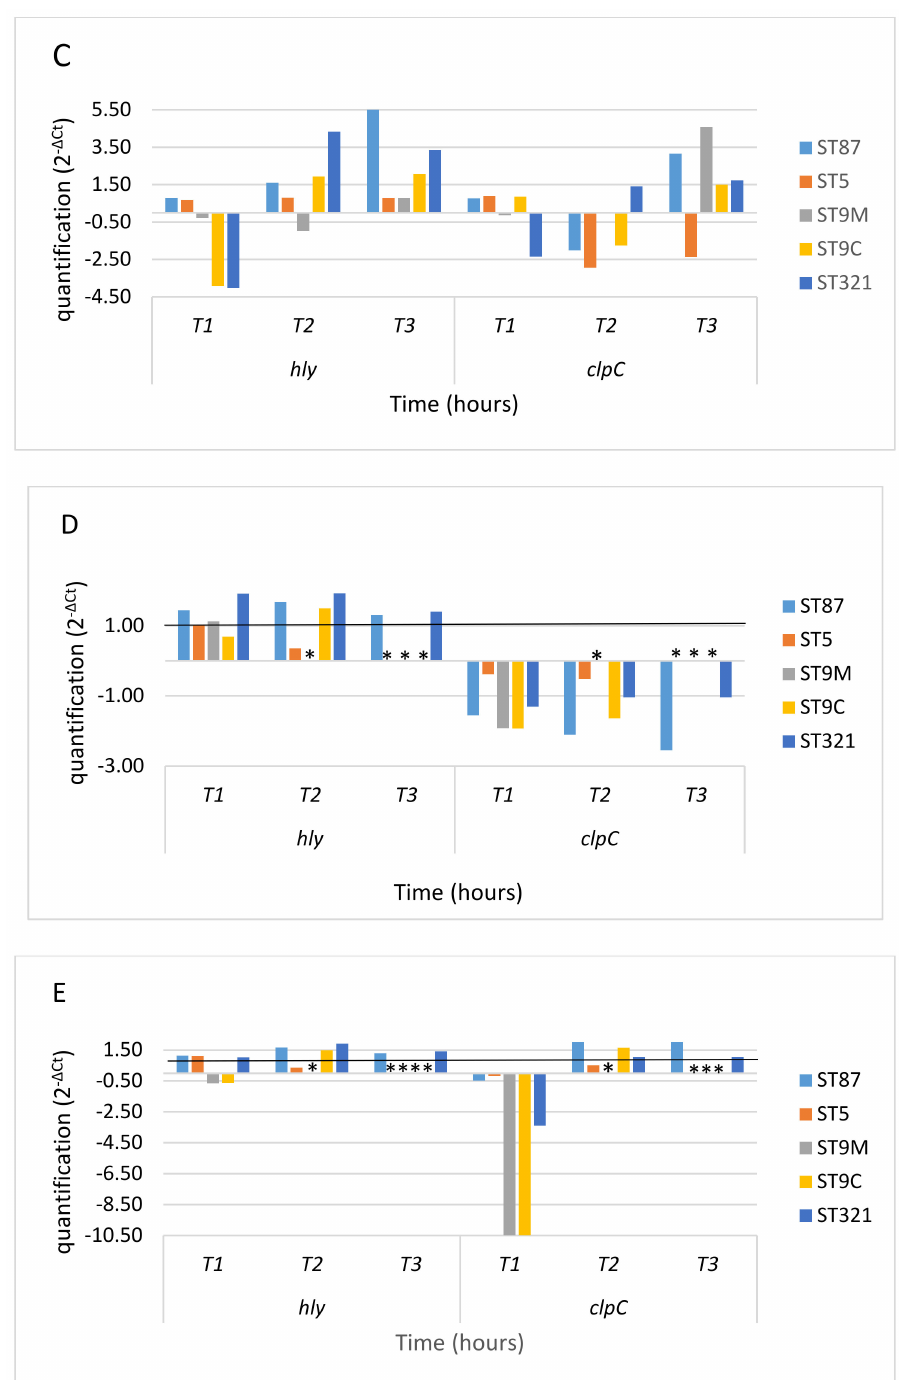
Figure 1. Expression of hly and clp C genes during oxidative stress. Transcripts of hly and clp C were normalized to those of the ldh gene. Expression of hly and clp C after 1, 2 and 3 hours is shown relative to that before the addition of the oxidizing agents. ( A ) Exposure to CHP at 37 ◦ C; ( B ) Exposure to CHP at 10 ◦ C; ( C ) Expression of hly and clp C in CHP at 10 ◦ C relative to that at 37 ◦ C; ( D ) Exposure to H 2 O 2 at 10 ◦ C; and ( E ) Expression of hly and clp C in H 2 O 2 at 10 ◦ C relative to that at 37 ◦ C. Black line: No di ff erences in gene expression with respect T 0 (value = 1). *: gene expression results were not studied because cell counts were below the detection limit. T1, T2 and T3: period of time after 1 hour (T1), 2 hours (T2) and 3 hours (T3) of oxidative stress conditions exposure in the L. monocytogenes